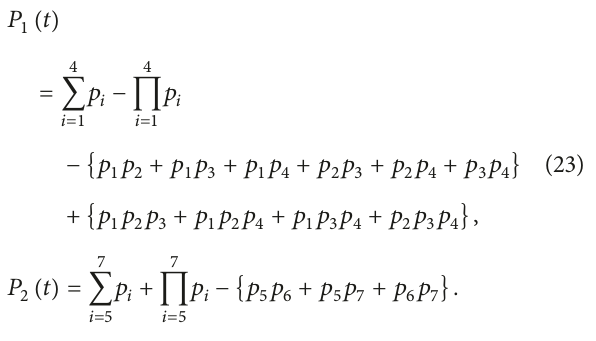
Figure 8: Block diagram of network correction quality module 𝑀 𝑁,3